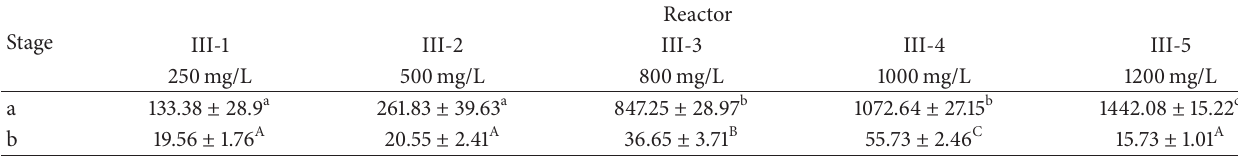
Table 3: Amount of target gene hsp in the inoculated reactors with different nicotine load.